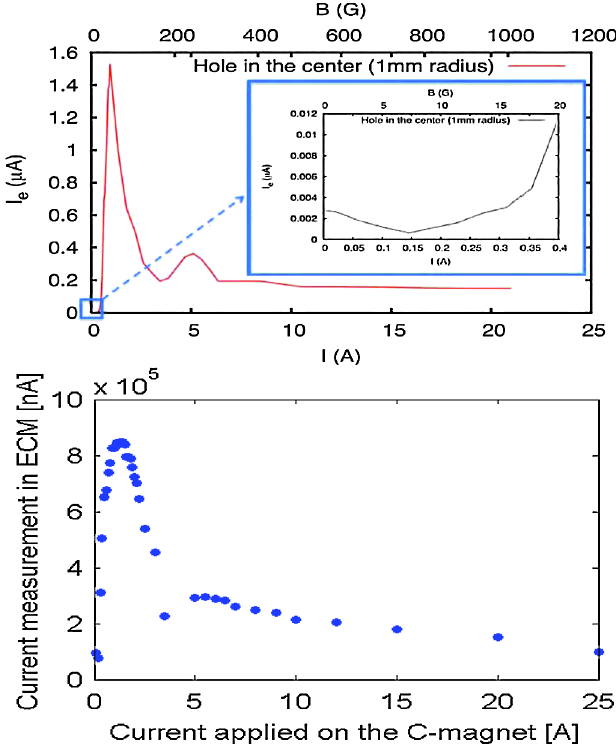
FIG. 11. The current of e-cloud on stainless steel as a function of current applied on the dipole. Top: E-cloud simulation of the total charge into the hole of 1 mm in radius in the center of the liner. Bottom: Measurement of the total charge detected by ECM. To be noticed: two maxima appear both in the simulation and in the measurements. The first maximum is due to the magnetic field dependence of the transmission of the ECM. At higher magnetic fields the cyclotron radius of secondary elec- trons is so small that they remain almost constant in the radius of their rotation which is of the same order of magnitude of the holes of the grid (see Fig. 1). This decreases the measured e-cloud at high fields. Therefore the second maximum is on the other hand expected as the real maximum of the measured e-cloud current.